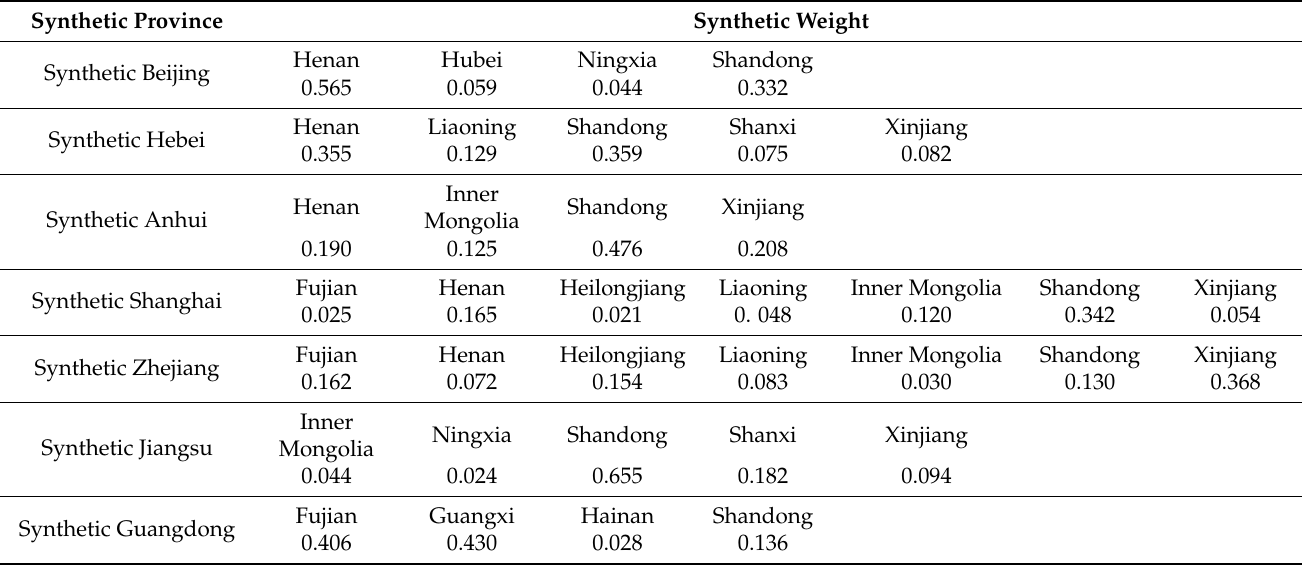
Table 5. Synthetic province weighting